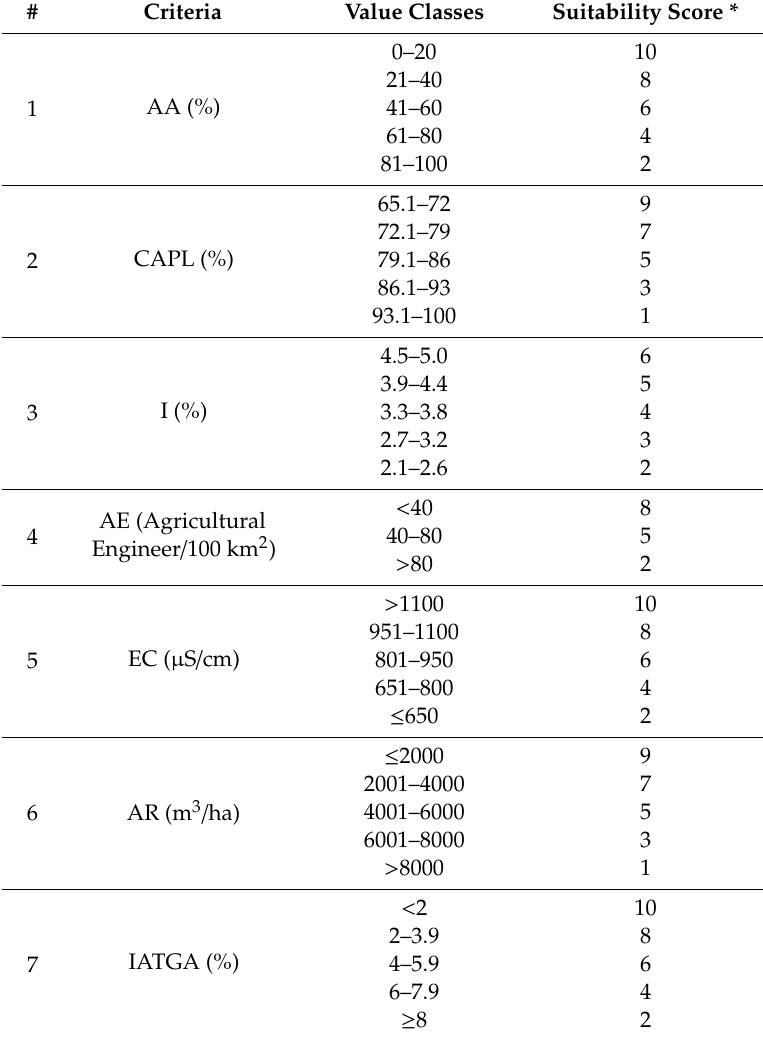
Table 5. AWP scores assigned for the sub-criteria for the West Bank case